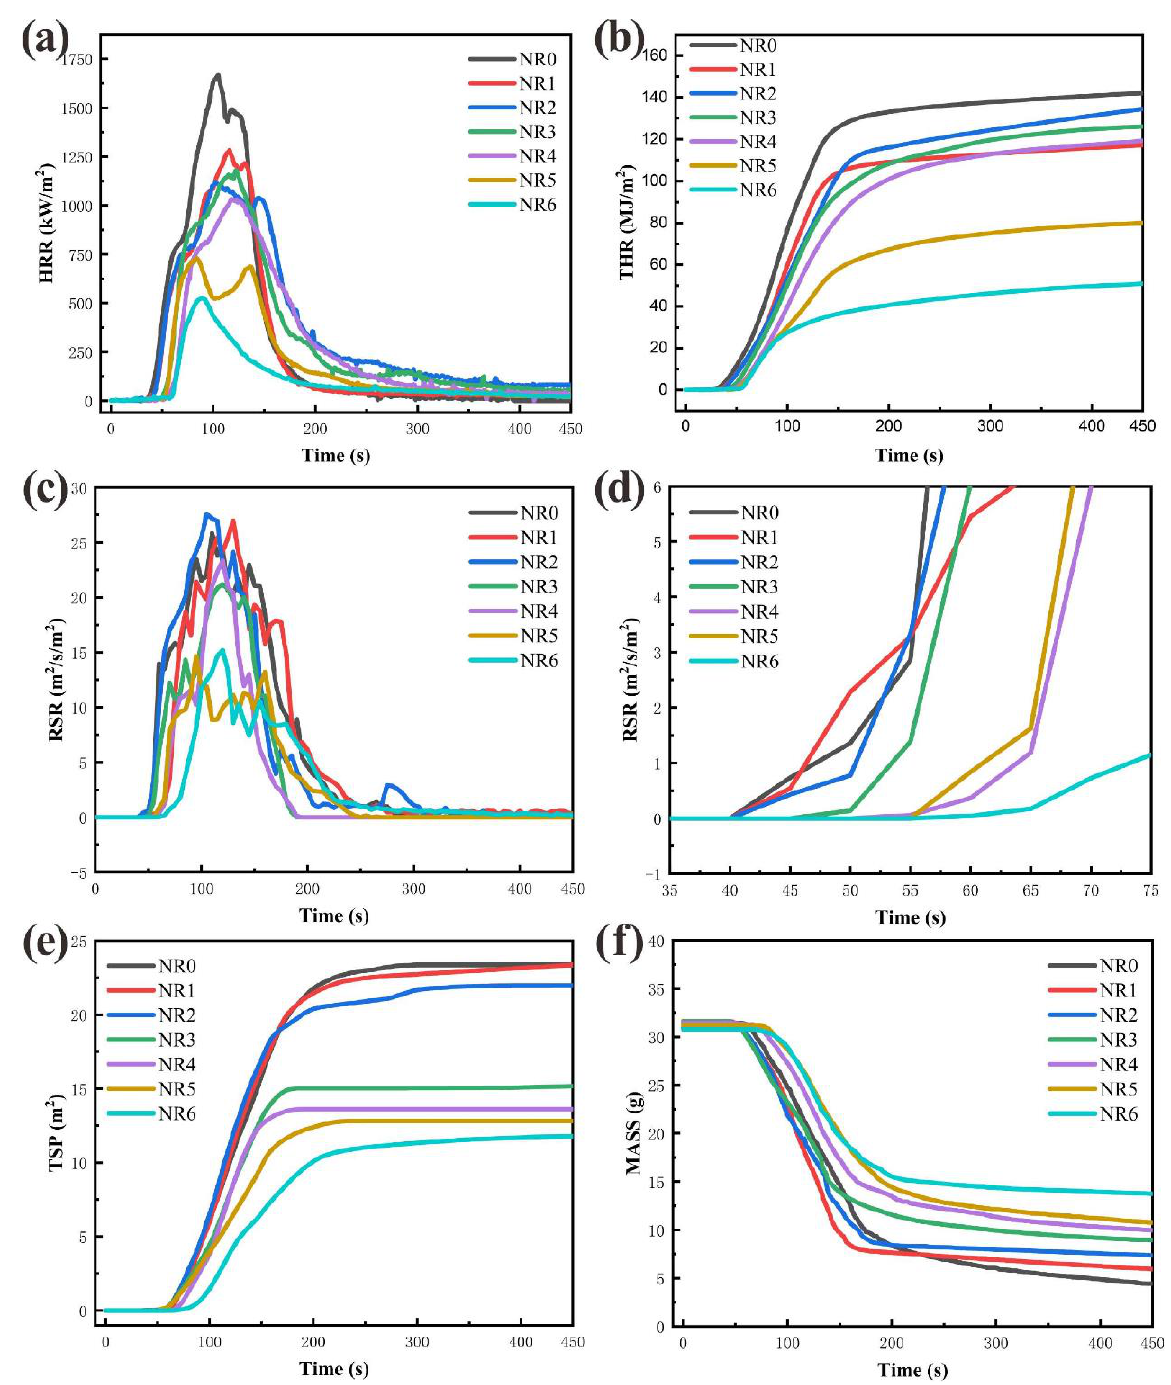
Figure 4. Cone calorimeter test process curve: ( a ) HRR; ( b ) THR; ( c ) RSR; ( d ) enlarged view of RSR; ( e ) TSP; ( f ) specimen mass.